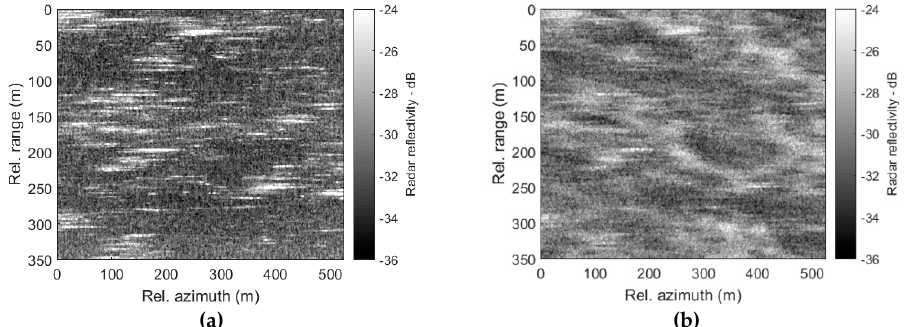
Figure 6. SETHI X-band SAR images (Run 3), grazing angle 10°, wind speed 7 m/s. ( a ) HH polarization, ( b ) VV polarization.